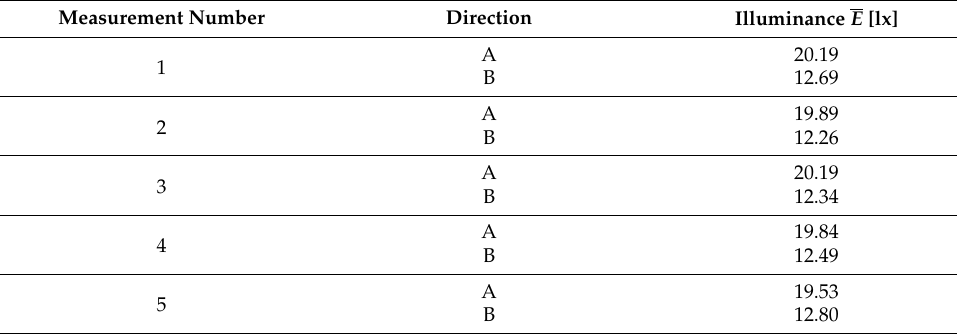
Table A8. Example of the results for measurement field No. 13.